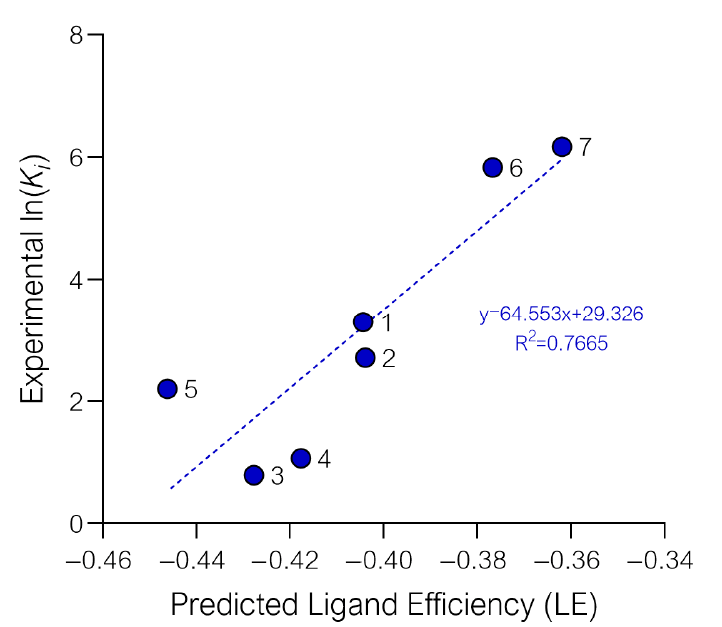
Figure 4. Correlation between experimentally determined ln( K i ) and predicted ligand efficiency.